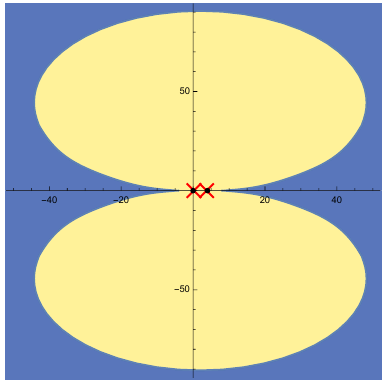
Figure 11. A view of the exclusion plot on the s -plane (in units of m 2 known zeros of S ( s ) are marked with red crosses (which are very close to the branch points s = 0 and 4 m 2 , marked by black dots). The possibility of unknown resonances is eliminated in the yellow 1